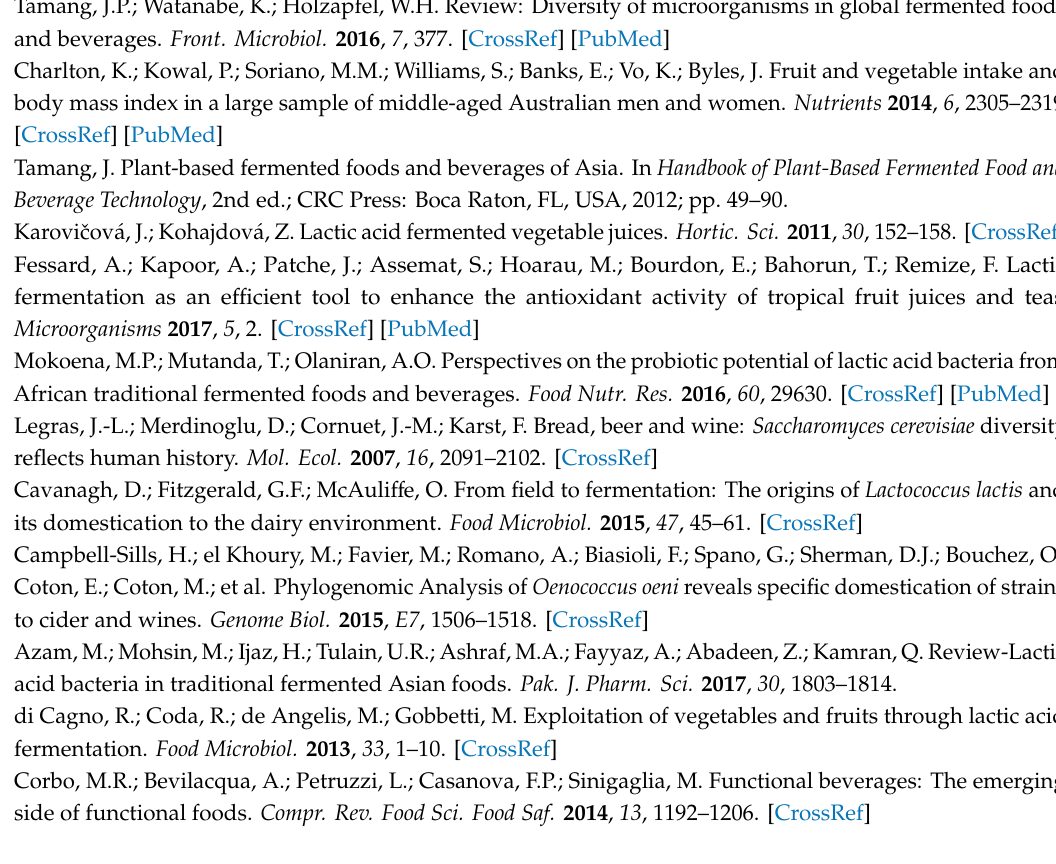
Table S1: Species of lactic acid bacteria, which were isolated from raw or spontaneously fermented vegetables and fruit; Table S2: Review of the recent studies on sugars and organic acids metabolism by LAB along fermentation of plant